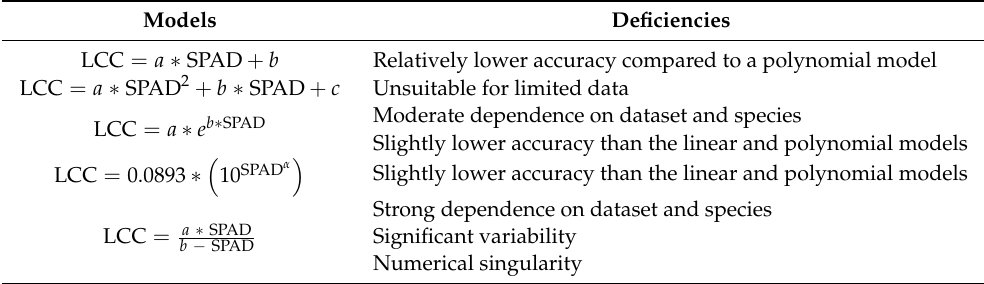
Table 5. Comparison of five functions for estimating the LCC with SPAD readings. Models